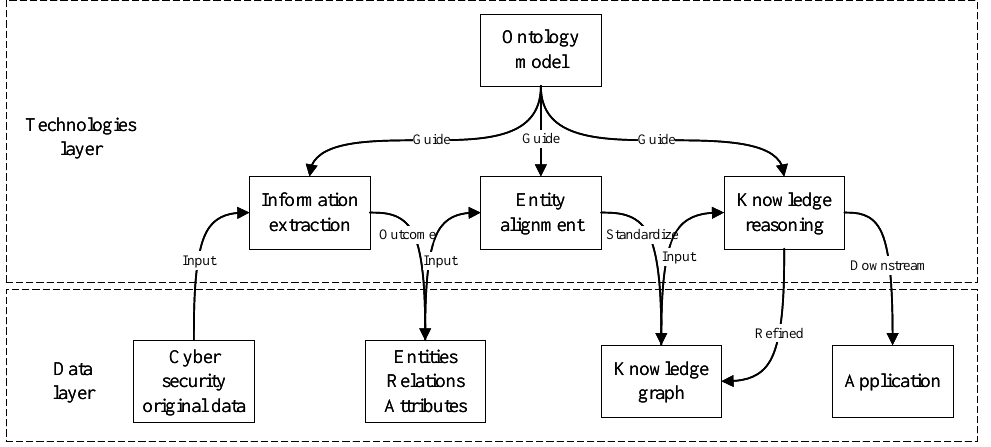
Figure 1. The construction framework of the cybersecurity knowledge